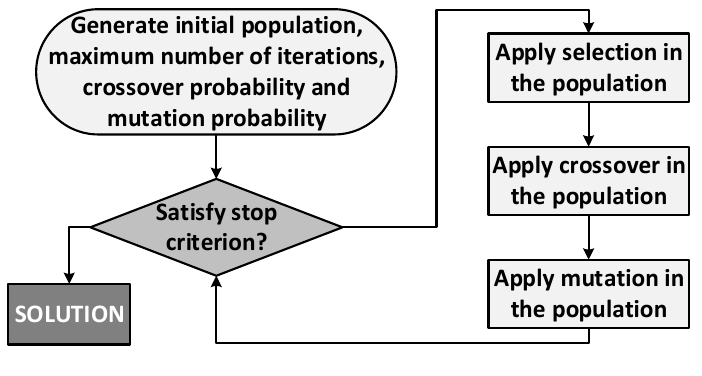
Figure 13. GA algorithm.